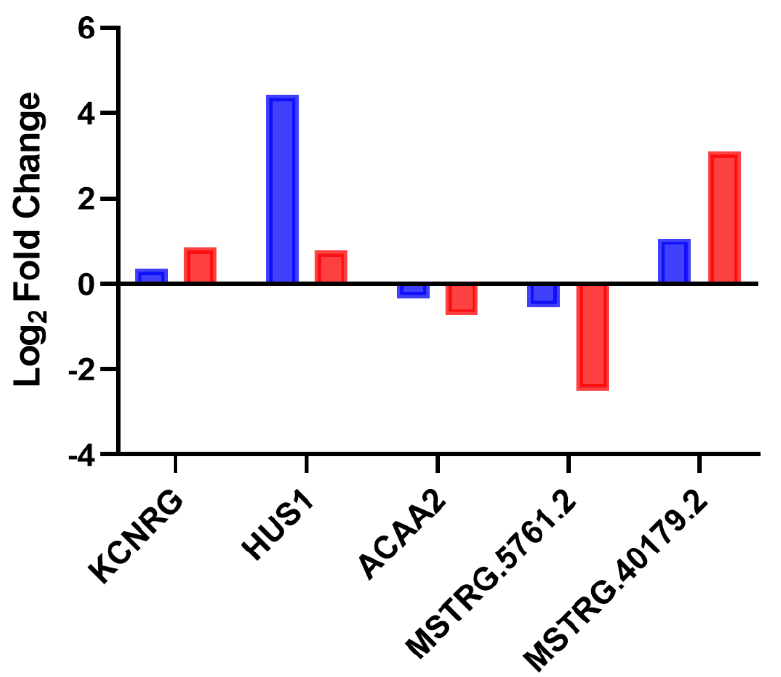
Figure 7. The RNA sequencing analysis data were verified by qRT-PCR. The relative expression levels of five differentially expressed RNAs were analyzed between RNA sequencing and qRT-PCR.